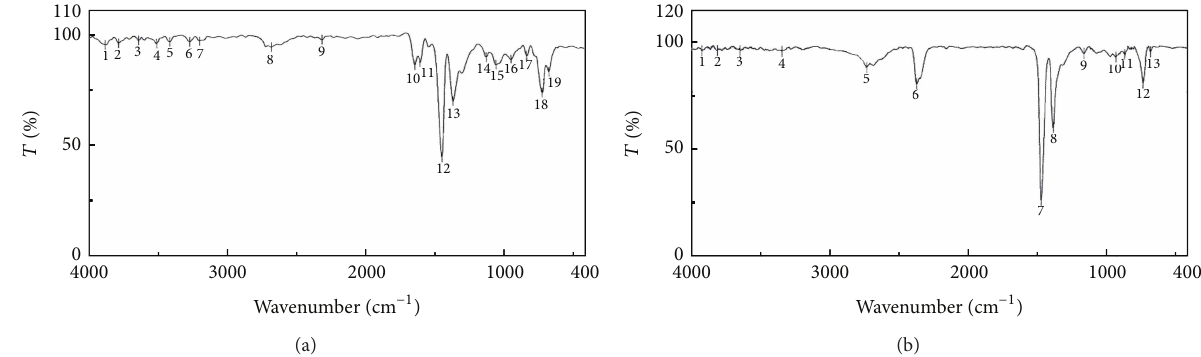
Figure 7: IR spectra of (a) INPMH and (b) scratched MS surface adsorbed INPMH film.